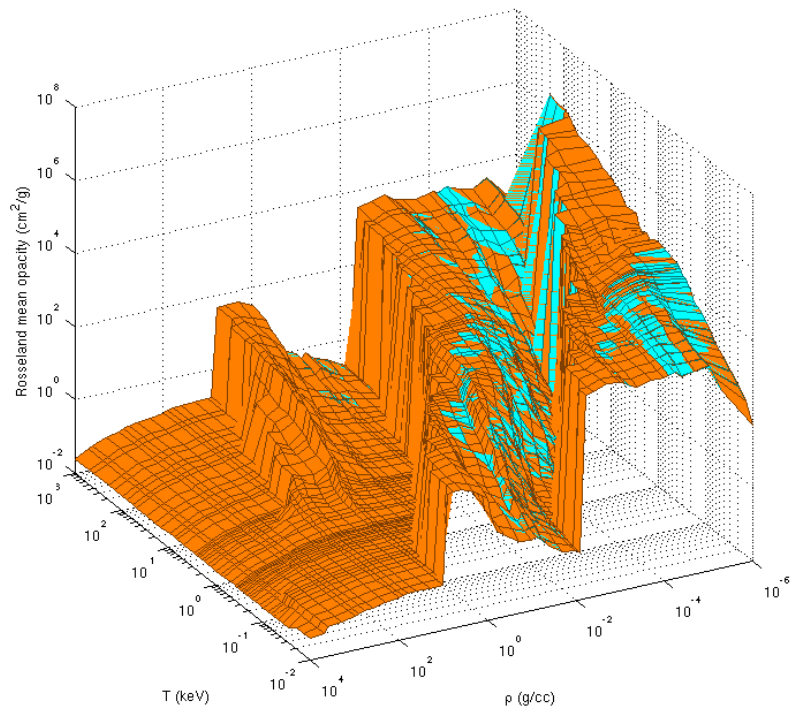
Figure 22. Iron Rosseland mean opacities of a calculation with a maximum number of 1000 supercon- figurations and a maximum number of 10,000 superconfigurations as a function of temperature and